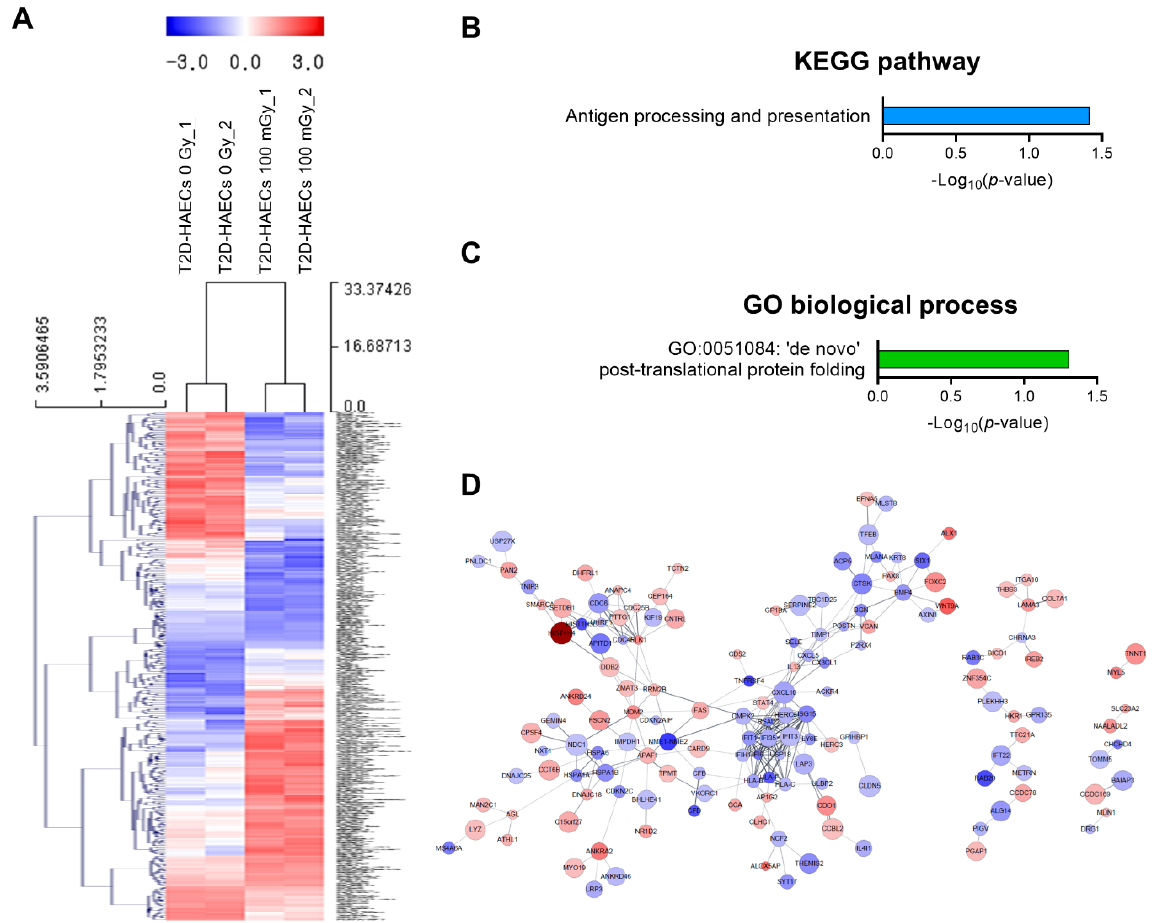
Figure 4. DEG analysis of low-dose radiation-related DEGs in T2D-HAECs. ( A ) Heatmap analysis with hierarchical clustering of DEGs in T2D-HAECs treated with 100 mGy irradiation. ( B ) Signifi- cant KEGG functional pathways related to DEGs in T2D-HAECs treated with 100 mGy irradiation ( p < 0.05, FDR q -value < 0.25). ( C ) Significant GO term of associated biological processes in DEGs in T2D-HAECs treated with 100 mGy irradiation ( p < 0.05). ( D ) The PPI networks associated with low-dose radiation responsiveness in T2D-HAECs visualized using the STRING plug-in of the Cytoscape program (version 3.9.1). Node colors represent the expression. The gradual change in color from blue to red corresponds to the change in the expression level (from down-regulation to up-regulation) in low-dose radiation-treated HAECs versus non-treated HAECs.